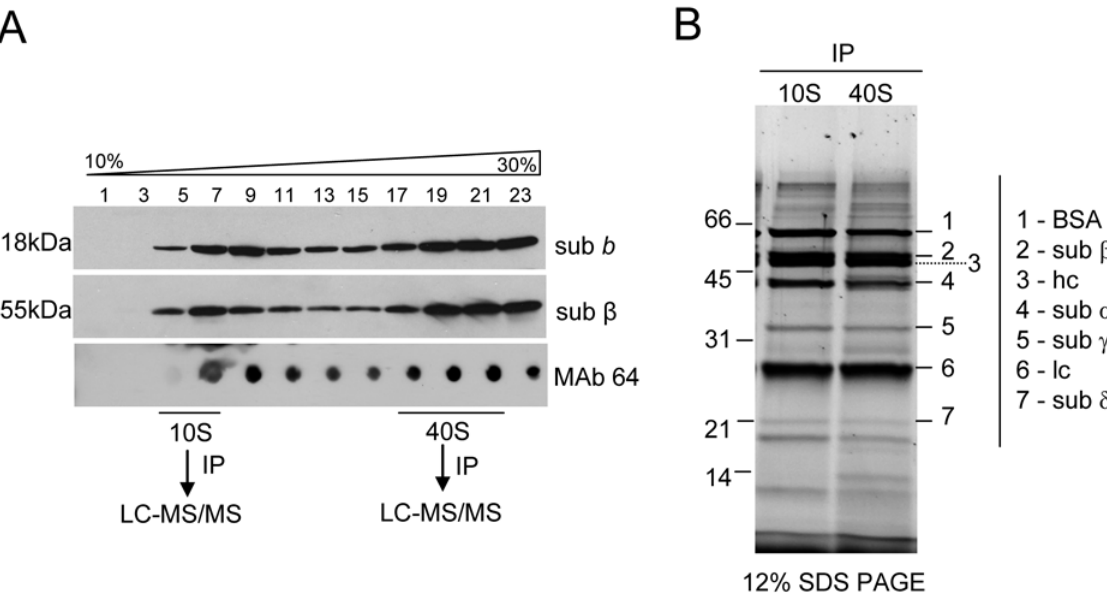
Figure 1. Glycerol gradient fractionation and immunoprecipitation of F 0 F 1 -ATP synthase complex from T.brucei mitochondria. (A) Western blot and native dot blot analyses of the 10–30% glycerol gradient-fractionated cleared mitochondrial lysate were performed using polyclonal antibodies against subunit b and b , and monoclonal antibody mAb64 to determine the sedimentation pattern of the F 0 F 1 -ATP synthase complex. MAb64 was further used to immunoprecipitate (IP) complexes from the 10S and 40S peaks and their protein compositions were analyzed by liquid- chromatography tandem mass spectrometry (LC-MS/MS). (B) Immunoprecipitated 10S and 40S complexes were fractionated on a 12% SDS PAGE gel and stained by Sypro Ruby. Protein bands corresponding to immunoglobulin heavy (hc) and light (lc) chains as well as predicted positions of F 1 subunits a , b , c and d and the size standards are indicated.